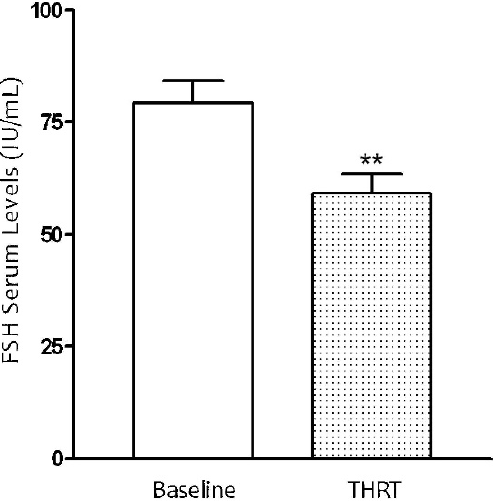
Figure 3 - Effect of nanoparticle formulation emulsion on FSH serumconcentrationin 66women receiving transdermal hormone replacement therapy (THRT) for 60 months. The nanoemulsion was administered topically to postmenopausal women. Mean values are shown, and the SEs are indicated by error bars. * p , 0.05 was considered significantly different from baseline values